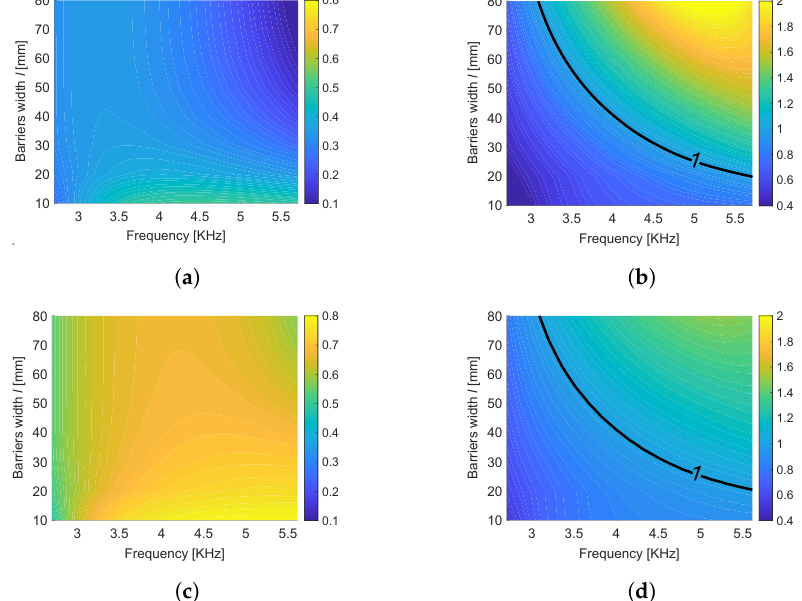
Figure 9. The contours ( a , b ) show respectively the indexes IC and the AIC for the first optimal cavity widths 2 ˜ d 1 , while ( c , d ) for the second optimal cavity widths 2 ˜ d 2 . The plots are obtained using analytic expressions.